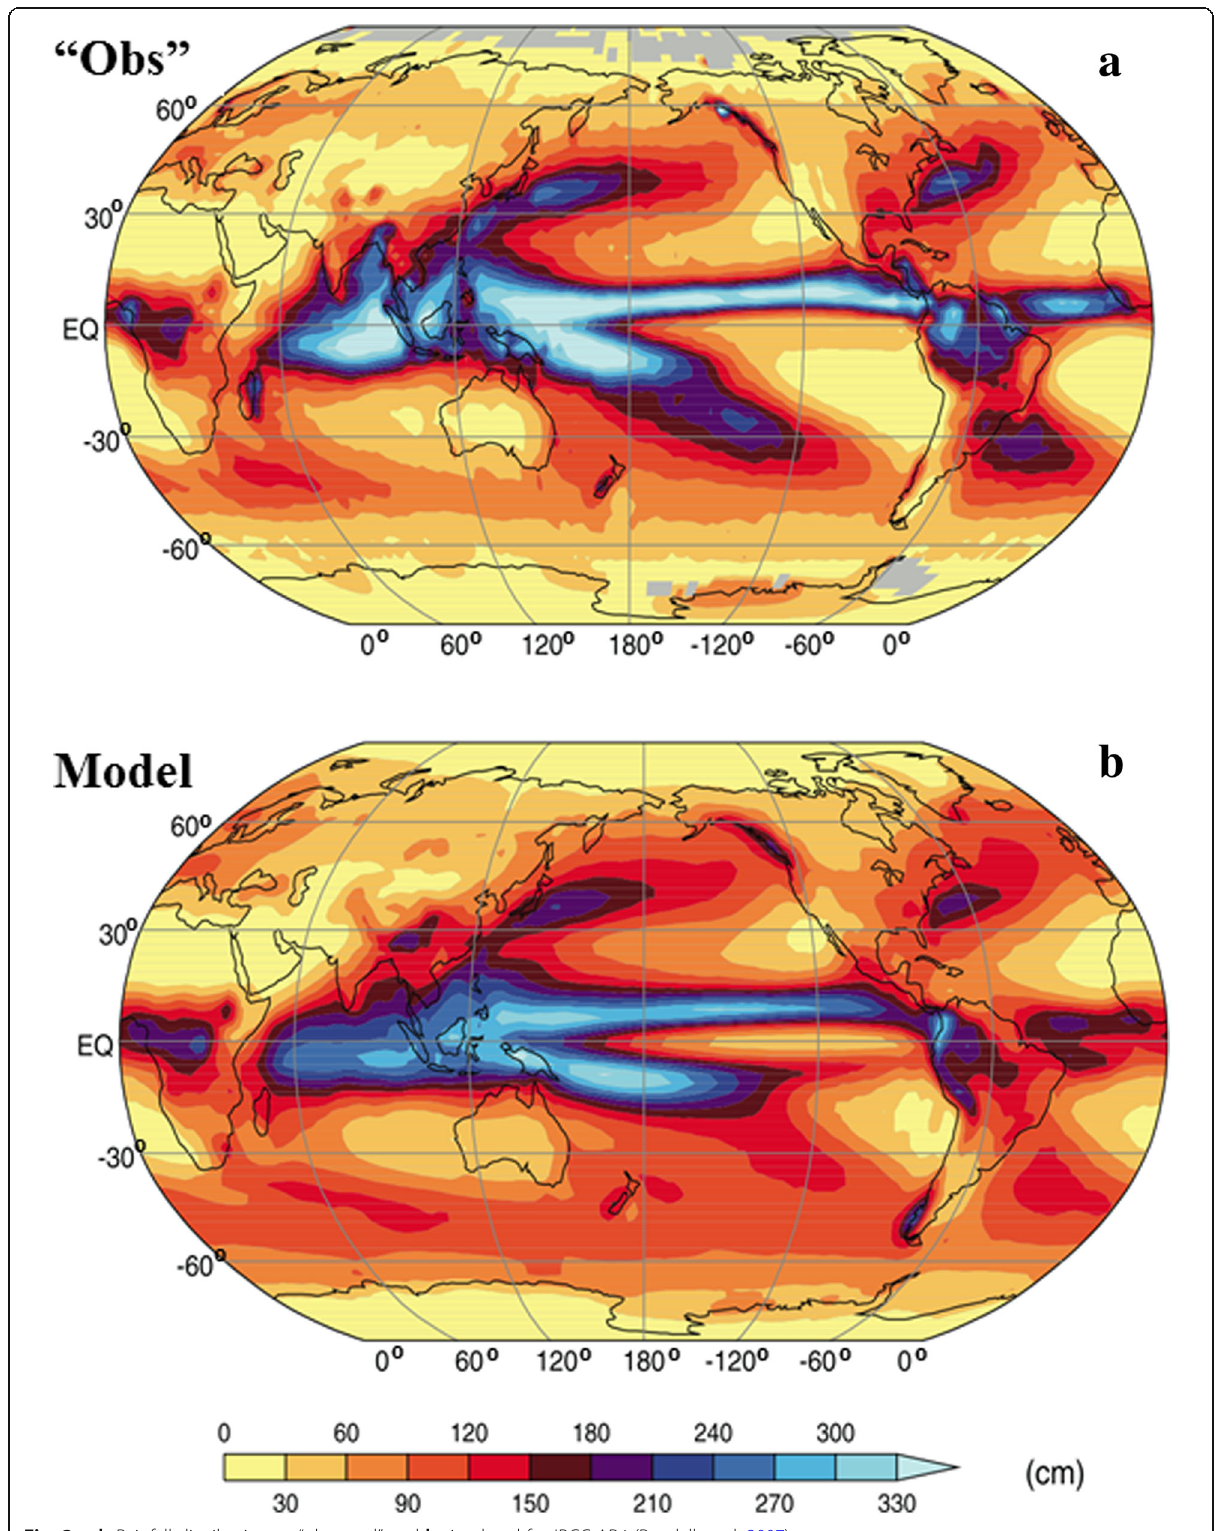
Fig. 3 a , b Rainfall distributions a “ observed ” and b simulated for IPCC AR4 (Randall et al.